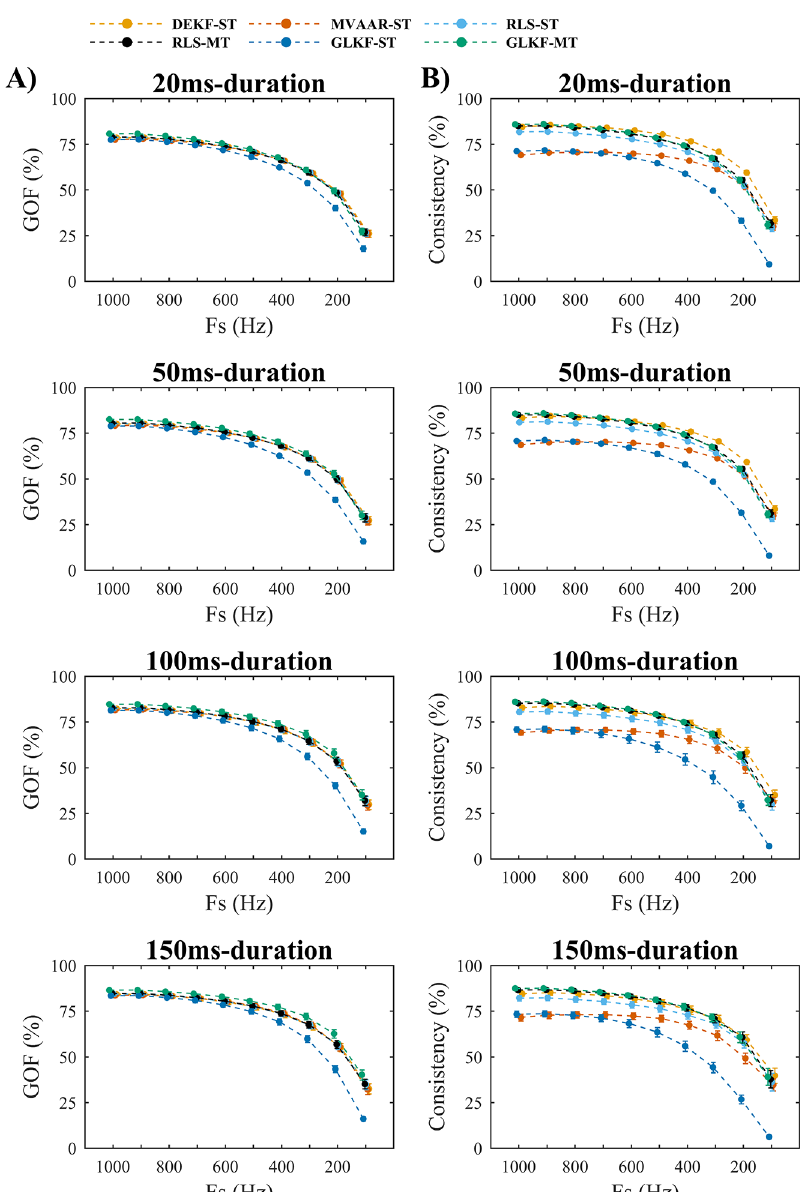
node 1 to node 2 (Fig 1D): 20 ms (first row), 50 ms (second row), 100 ms (third row), and 150 ms (fourth row). In each plot the results are reported varying sampling rate Fs, for the four recursive algorithms and the two ways of exploiting multiple trials: single-trial modeling and multi-trial modeling, available only for RLS and GLKF. Error bars represent 95% CI of the mean value computed across 50 simulations.